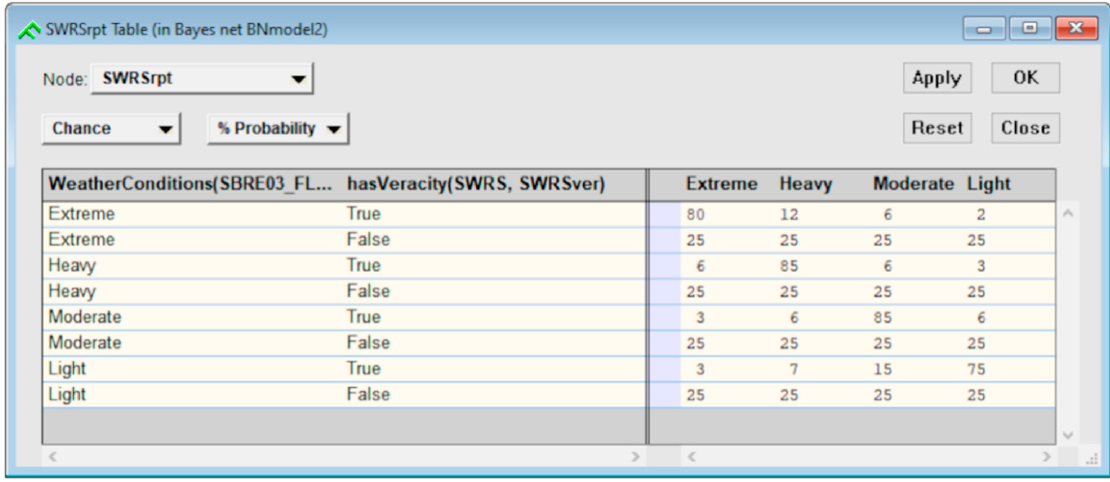
Figure 11. Conditional Probability Table for node ProducedWeatherReport (SWRS, SWRSrep).